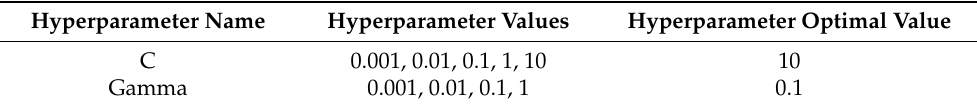
Table 6. Support vector machine best hyperparameter combination after hyper-tuning.